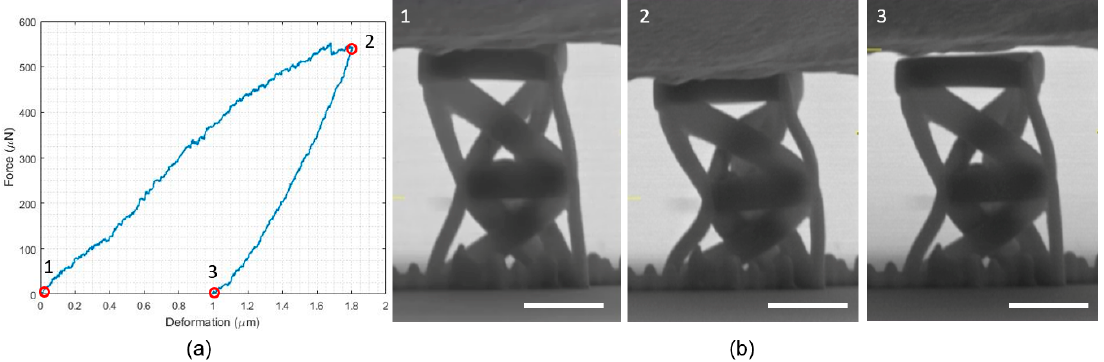
Figure 6. Mechanical testing on a single unit cell. ( a ) The force-displacement plot for an individual unit. ( b ) Snapshots of the structure at different times during testing (cf. Video S2: Individual unit). unit. ( b ) Snapshots of the structure at di ff erent times during testing (cf. Video S2: Individual unit). The white scale bar for each SEM figure is 5 μ m. The white scale bar for each SEM figure is 5 µ